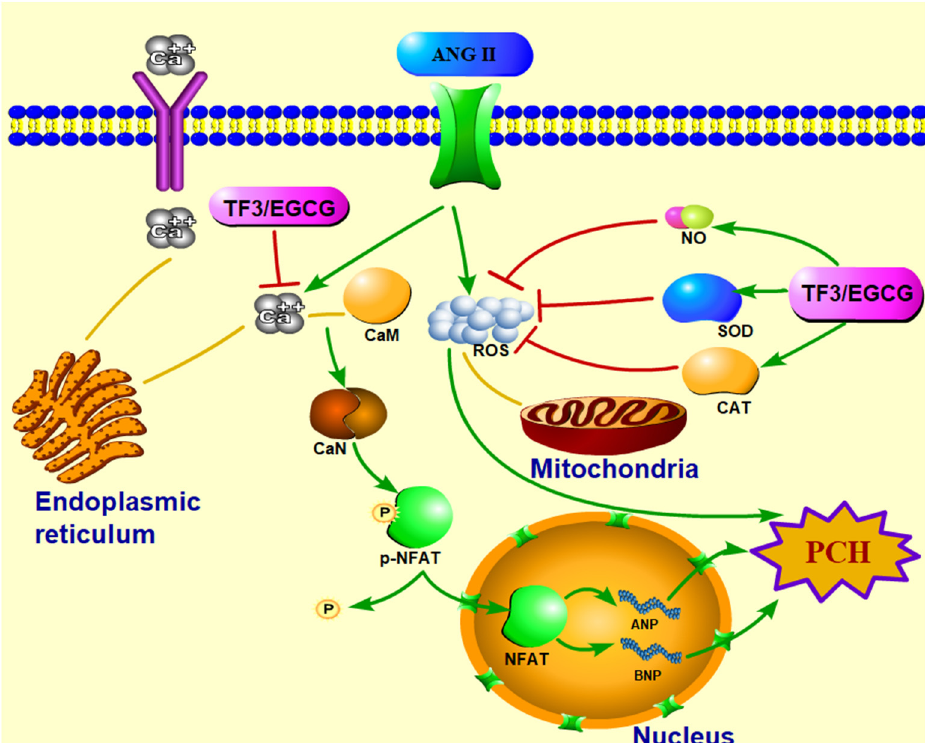
Figure 7. Diagrammatic sketch of TF3 on preventing H9c2 cells pathological cardiac hypertrophy induced by angiotensin II via CaN-NFAT signal pathway.